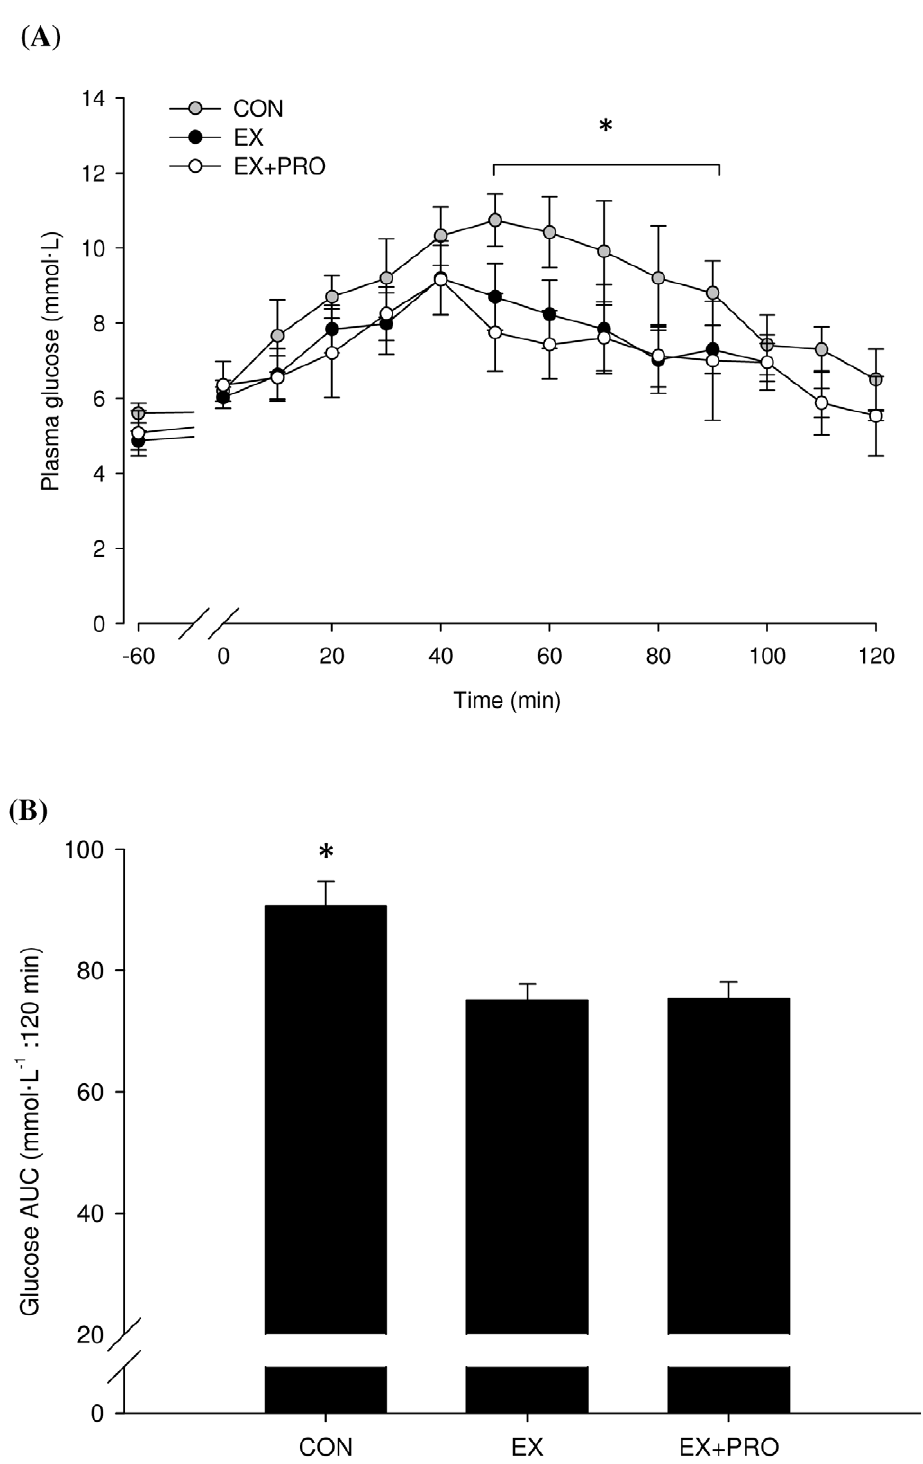
Figure 2. Plasma glucose concentration (A) and AUC (B) during OGTT 24 h following resistance exercise in untrained volunteers. Groups as per Table 1. Values are means 6 SEM; n =8 per group. *: significantly greater glucose concentration/AUC for CON compared with EX and EX + PRO ( P , 0.05). doi:10.1371/journal.pone.0020613.g002 9.1- and 11.1-fold above basal fasted values for CON, EX and EX + PRO, respectively peaking 30–40 min after feeding (Figure 3A). Plasma insulin AUC during OGTT was significantly